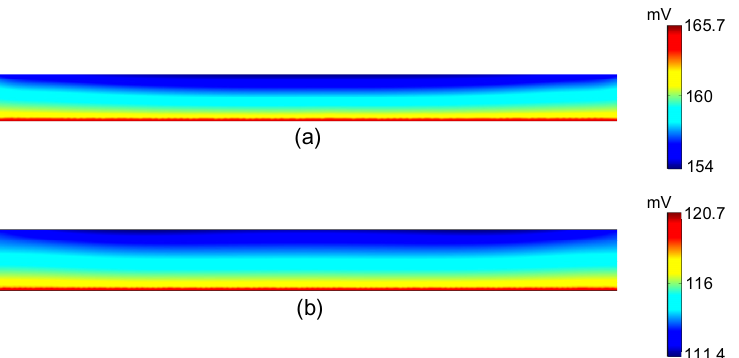
Figure 10. Potential distributions of contact plane: ( a ) w/o and ( b ) w/ optimization.